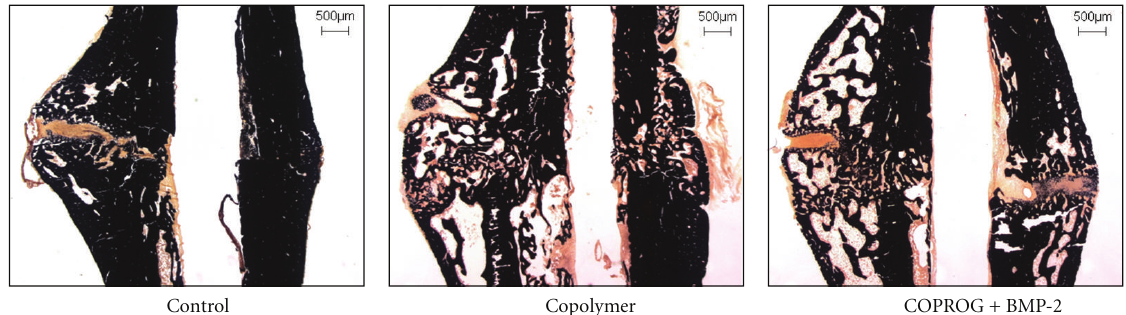
Figure 4: Histological sections of the fracture region (control, copolymer, and COPROG + BMP-2) after 42 days in v. Kossa staining.